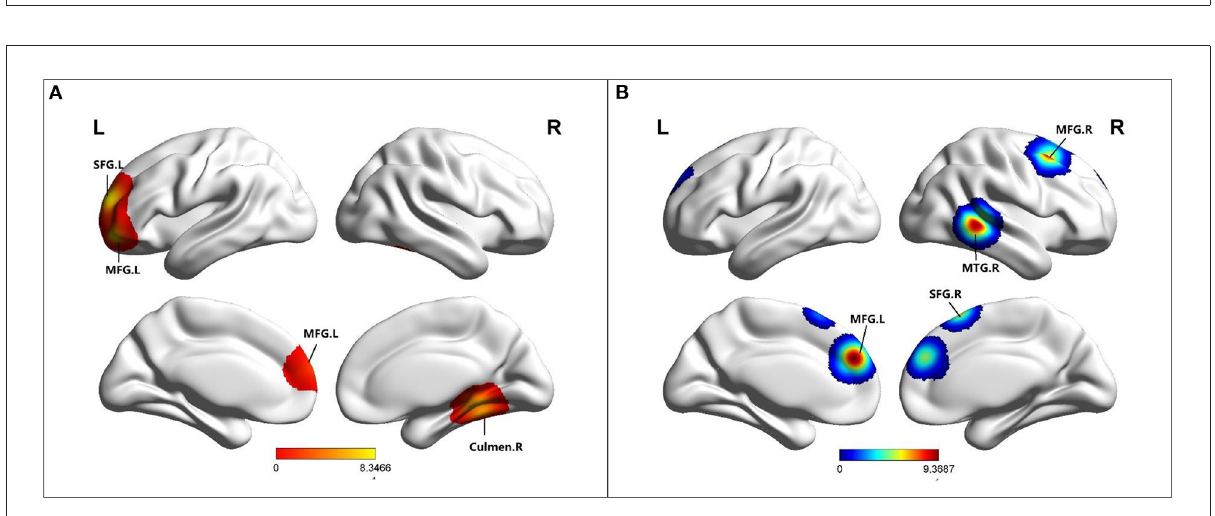
FIGURE3 (A) Brain regions showing increased ALFF in MCI patients compared to HCs. (B) Brain regions showing decreased ALFF in MCI patients compared to HCs. MCI, amnestic mild cognitive impairment; HCs, healthy controls; ALFF, the amplitude of low-frequency fluctuation; SFG, superior frontal gyrus; MFG, middle frontal gyrus; MTG, middle temporal gyrus; R, right; L,